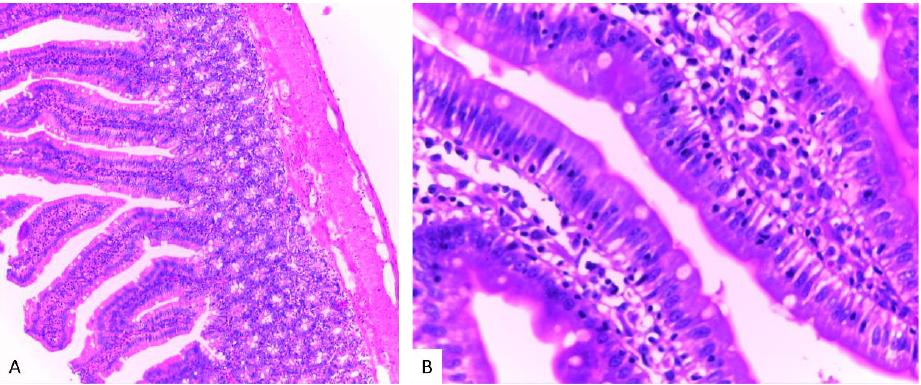
Figure 10. Histological appearance of the small intestine in animals in group II (H&E stain, 20X). Histological analysis in groups treated with MSB, MM or their combination (group III, IV, V), revealed no visible injuries to the structure of intestinal mucosa or other layers of the intestinal wall. (Figures 11–13).